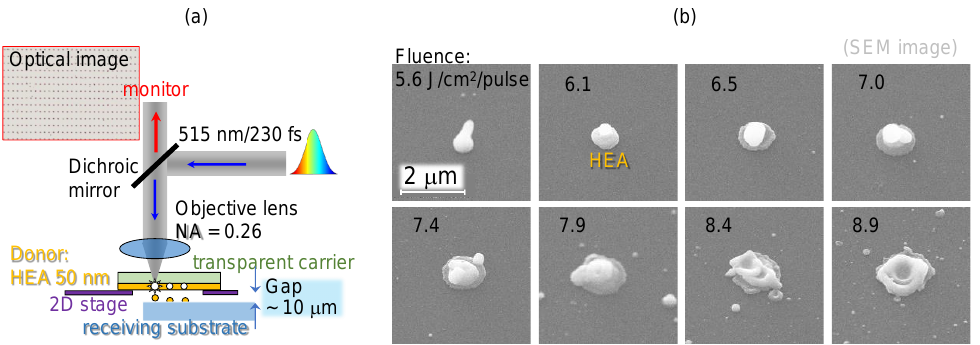
Figure 3. ( a ) LIFT of HEA film. ( b ) SEM images of single sub-1 µ m particles of CoCrFeNiMo 0.2 transferred on a cover glass at different fluences per pulse (J/cm 2 /pulse) under NA = 0.26 focusing. Laser irradiation: 230 fs, 515 nm. Thickness of HEA was 50 nm.